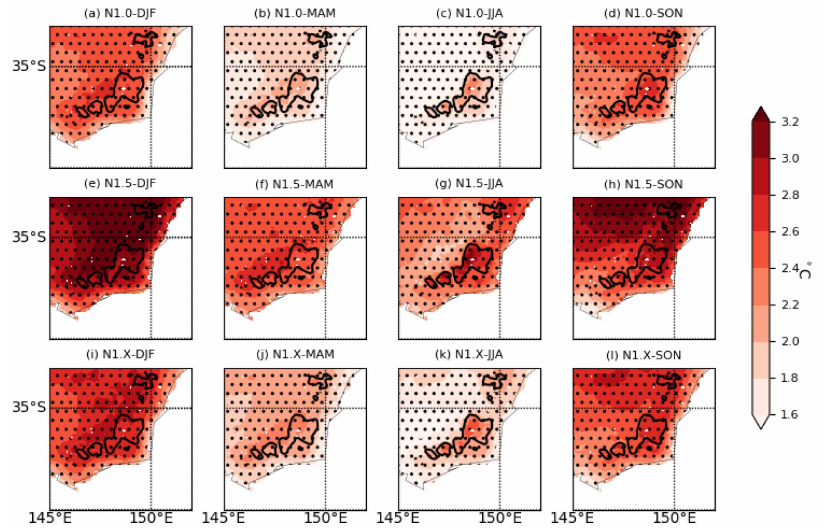
Figure 7. Projected seasonal changes in maximum temperature for N1.0, N1.5 and N1.x for 2060–2079 relative to 1990–2009. Stippling indicates statistically significant changes using a non-parametric Mann-Kendall test at the 95% confidence level. The black solid lines are the 1200 m contour where the high elevation areas are.